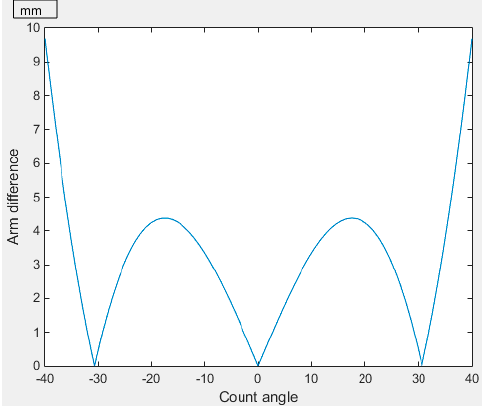
Figure 14. Curve of the arm of force difference of a cylinder with steering angle.